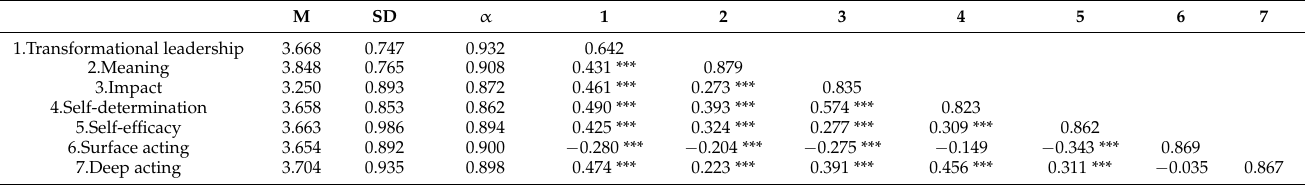
Table 1. Mean, standard deviations, correlations, Cronbach alpha coefficient, and